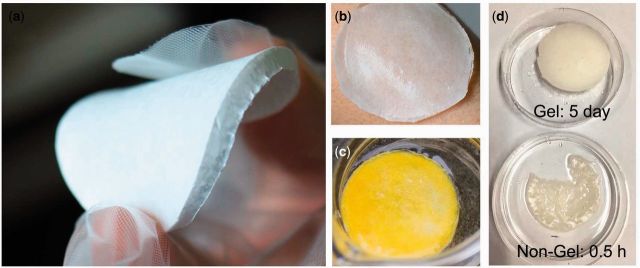
(a) Photos of the SF/PVA blend scaffolds, (b) the swollen hydrogel scaffold on the skin, (c) the sample after immersed in the release medium for 5 days and (d) the effect of gelation process